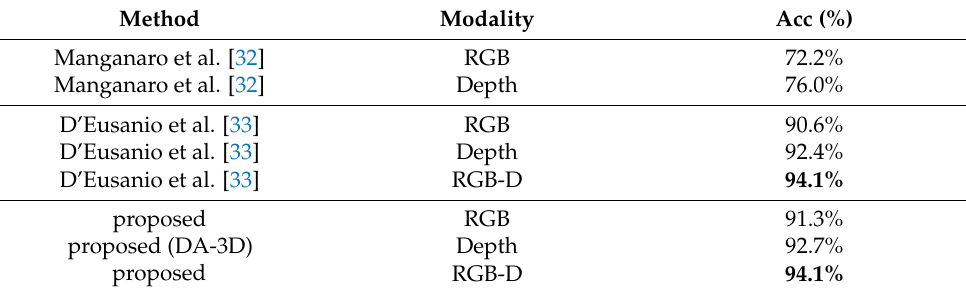
Table 2. Comparison with state-of-the-art methods in